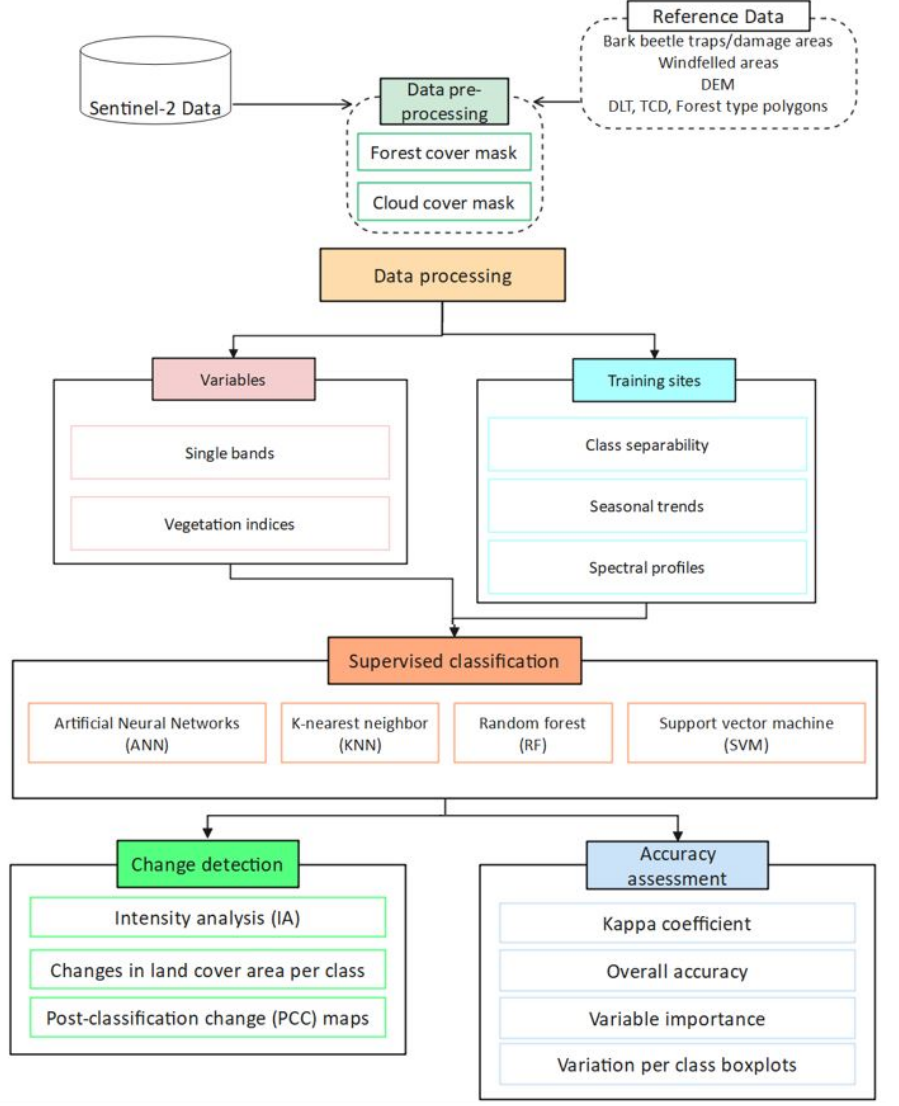
Figure 4. Workflow diagram .